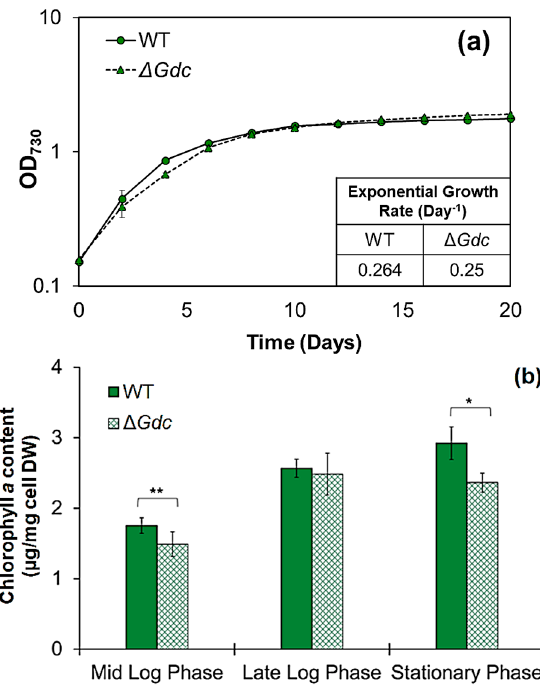
Figure 3. Growth and pigment analysis. ( a ) Comparison of growth by measuring the optical density of cultures at 730 nm. ( b ) Chlorophyll a content at various growth phases of the Synechocystis wild- type (WT) and mutant (M) strain, grown in BG11 medium and in BG11 medium supplemented with kanamycin (25 µg mL − 1 ), respectively. Results represent the mean ± standard deviation (SD) of experiments conducted in triplicate ( n = 3). The error bars denoting the SD values in ( a ) cannot be seen since the SD is smaller than the size of the symbol. In ( b ), the differences between means of the individual groups were analysed using one-way analysis of variance (ANOVA) via GraphPad Prism 9.3.1 software (San Diego, CA, USA). * p < 0.05, ** p < 0.01, versus WT cells.